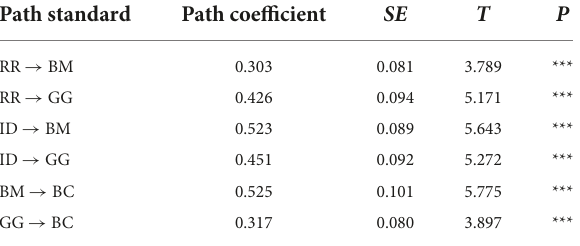
TABLE 6 Path coefficient of structural equation modeling